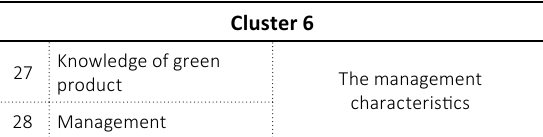
Table 7. Codes comprising Cluster 6